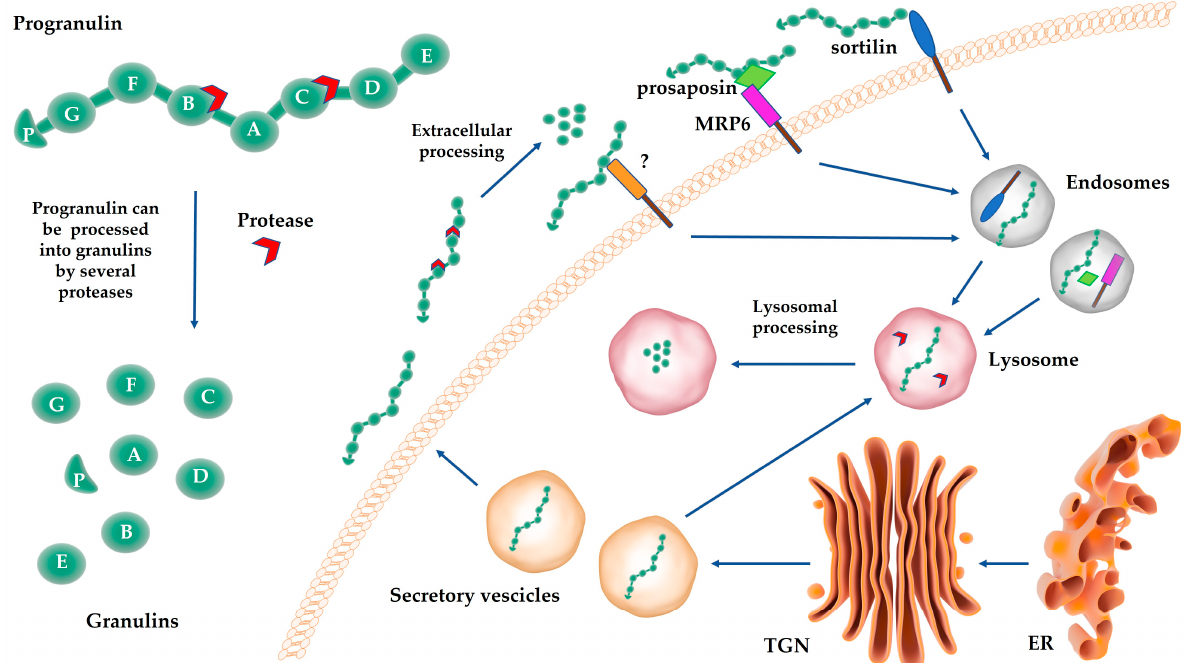
Figure 1. Progranulin structure, processing and trafficking. The growth factor progranulin is a modular protein containing seven and half non-identical, cysteine-rich tandem repeats, known as granulin domains. Progranulin can be processed by several proteases into single granulin modules. Progranulin is released into the extracellular environment by regulated exocytosis. Extracellular progranulin can be internalized in a sortilin- or prosaposin-dependent manner and sorted into lysosomes but can also reach the lysosomes diverting from the secretory pathway. In lysosomes, progranulin is processed by cathepsin L into granulins. Whether progranulin might be endocytosed in a sortilin- and prosaposin-independent manner through the binding to other receptors is still not fully defined. ER: endoplasmic reticulum. TGN: trans-Golgi network.